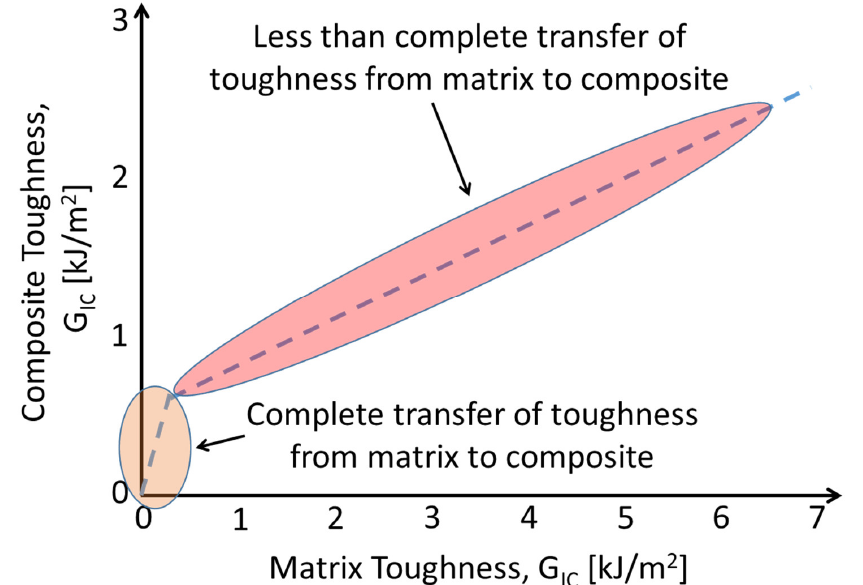
Figure 10. Mode I interlaminar fracture toughness of composites and matrix toughness [54] .